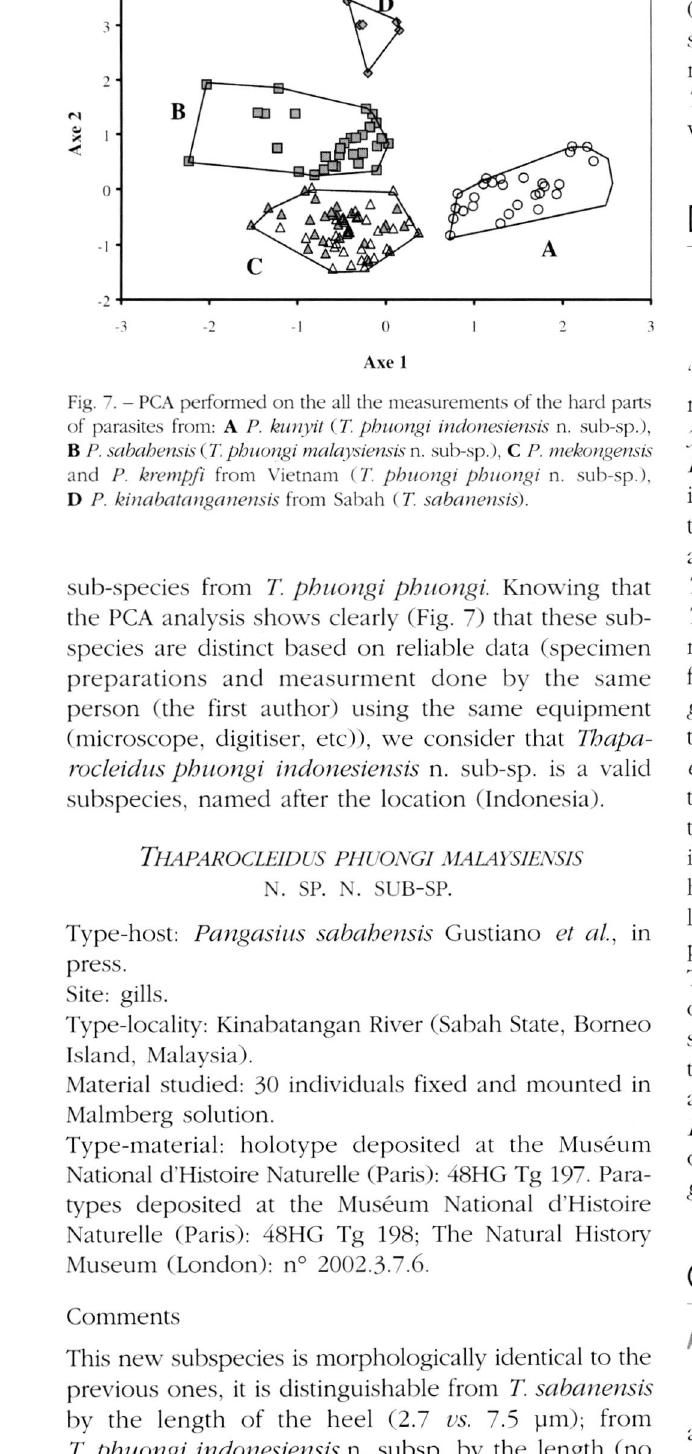
Fig. 7. — PCA performed on the all the measurements of the hard parts of parasites from: A P. kunyit (T. phuongi indonesiensis n. sub-sp.), B P . sabaheiisis(T.phuongi malaysiensis n. sub-sp.), C P. mekongensis and P. krempft from Vietnam ( T . phuongi phuongi n. sub-sp.). D P. kinabatanganensis from Sabah ( T. sabanensis).